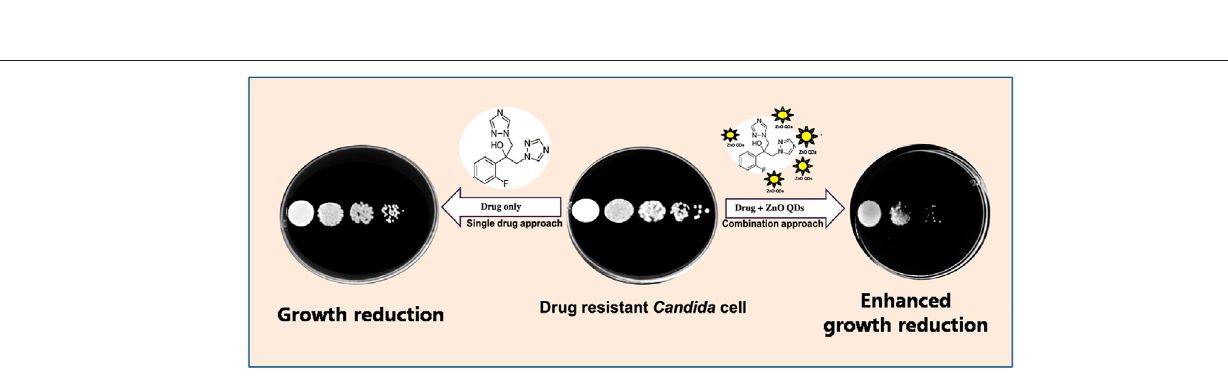
TABLE 4 | Concentrations of ZnO QDs and antifungal drugs used in different combinations for spot assays. Combination